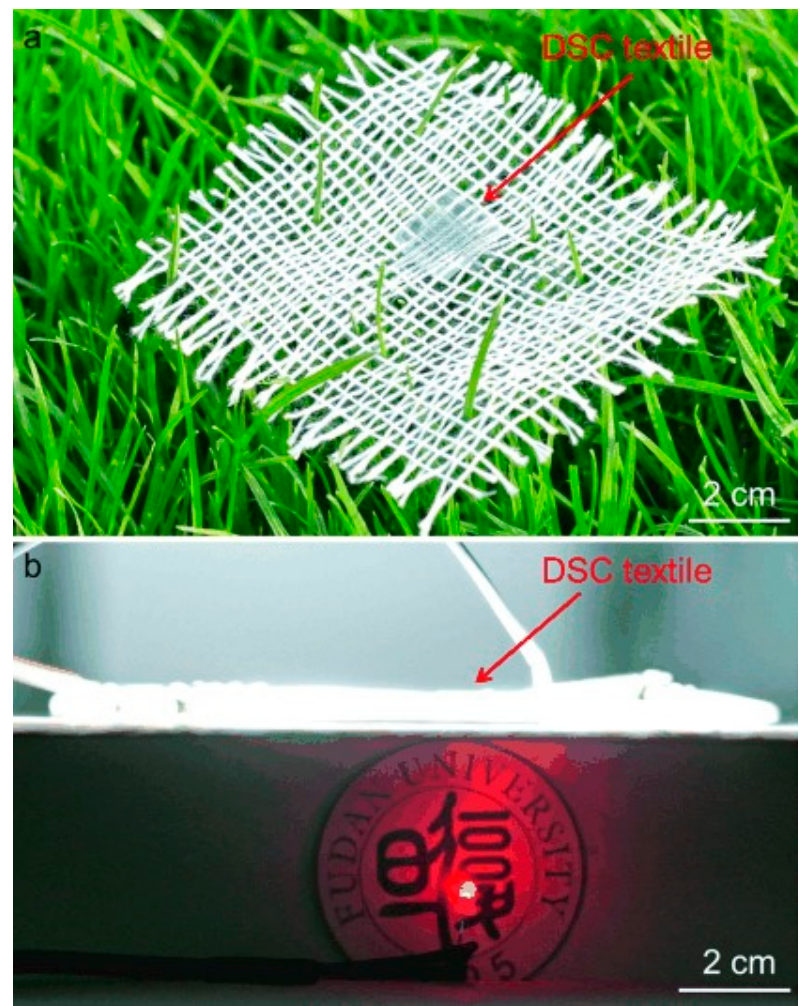
Figure 14. Photographs of the DSSC developed by Pan et al. ( a ) The DSSC. ( b ) The DSSC lighting up an LED. Reprinted from [150] with permission from Wiley.